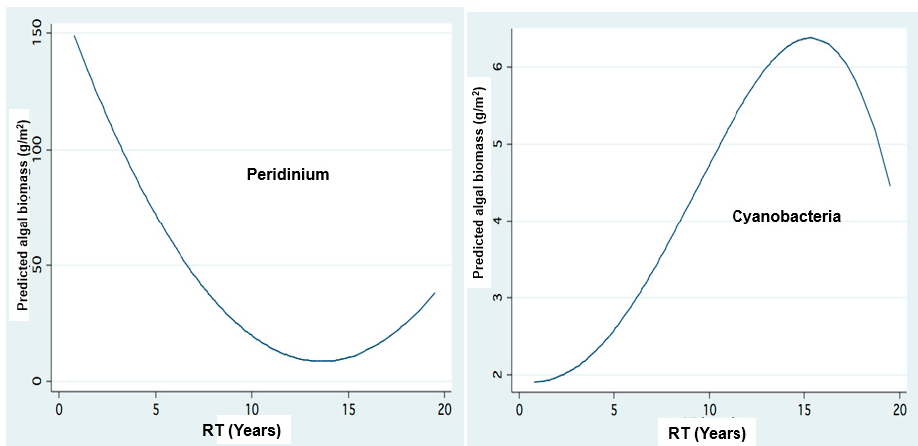
Figure 11. Biomass cfluctuations of Cyanobacteria and Peridiniun in relation to Residence Time (RT) length: FP regression between Residence Time length (RT) (Years) and Algal (Peridinium, Cyanophyta) Biomass (g/m 2 ).